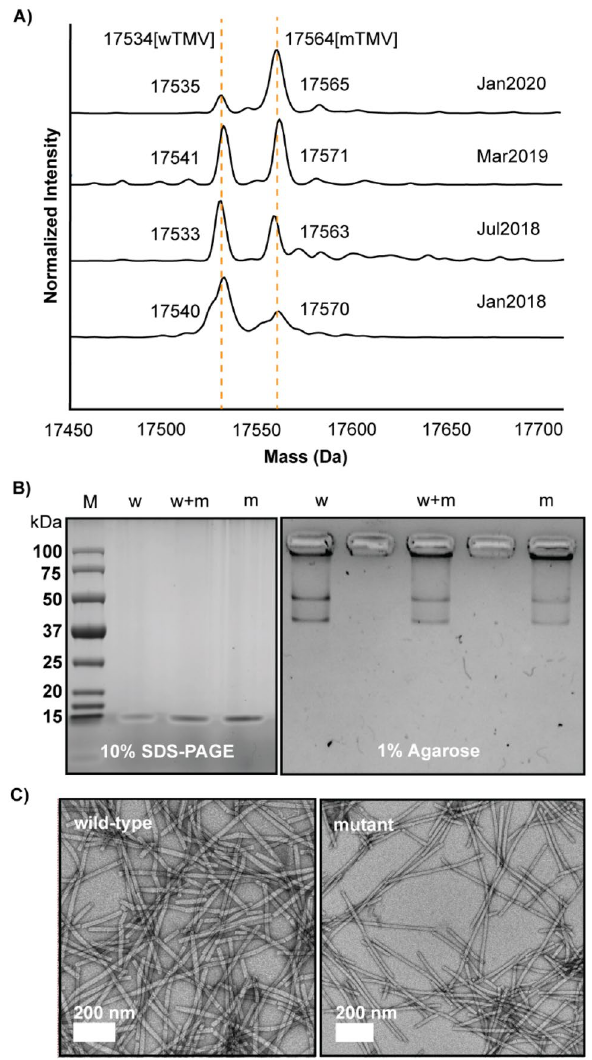
Figure 1. (A) Deconvoluted ESI–MS spectra of denatured TMV showing the emergence of a coat protein mutant from Jan 2018 till Jan 2020. The theoretical mass of wild-type TMV coat protein (wTMV) is 17,534 Da (including acetylation of the N-terminus). The mutant TMV coat protein (mTMV) is measuring approximately 30 Da larger. The relative abundance of the mTMV increased over time. (B) 10% SDS-PAGE and 1% agarose gel electrophoresis showing that the wTMV and mTMV migrate at the same rate. ‘w’ is mostly wTMV, ‘m’ is mostly mTMV, and ‘w + m’ is a mixture. (C) TEM micrographs of wTMV and mTMV showing that the rod-shaped viral morphology is not impacted by the